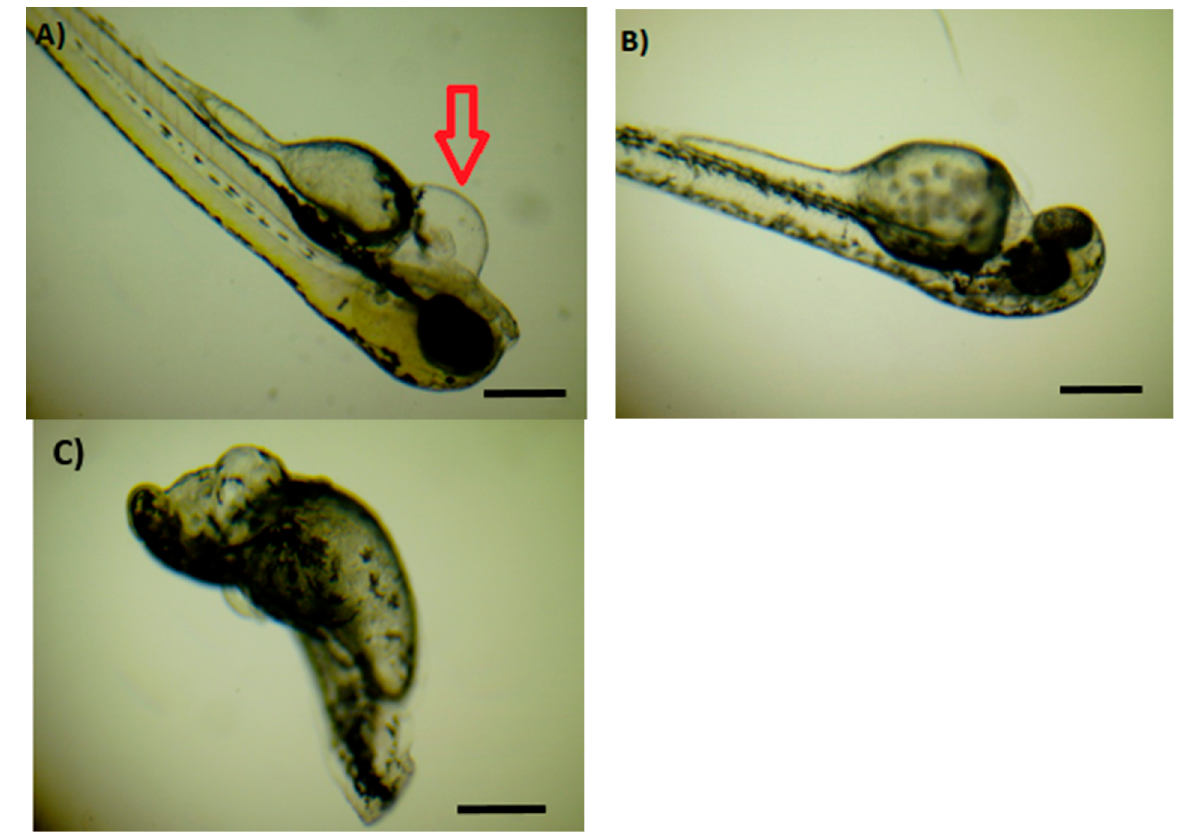
Figure 8. Pericard edema of zebrafish larvae in the group exposed to 250 µ g/L of 4-methylbenzylidene camphor at 72 h post fertilization (hpf) ( A ). Zebrafish larvae in the control group at 72 hpf ( B ). Total body deformation of zebrafish larvae in group exposed to 10 μ g/L of 4-methylbenzylidene camphor and octocrylene at 72 hpf ( C ). Scale bar = 0.4 mm.